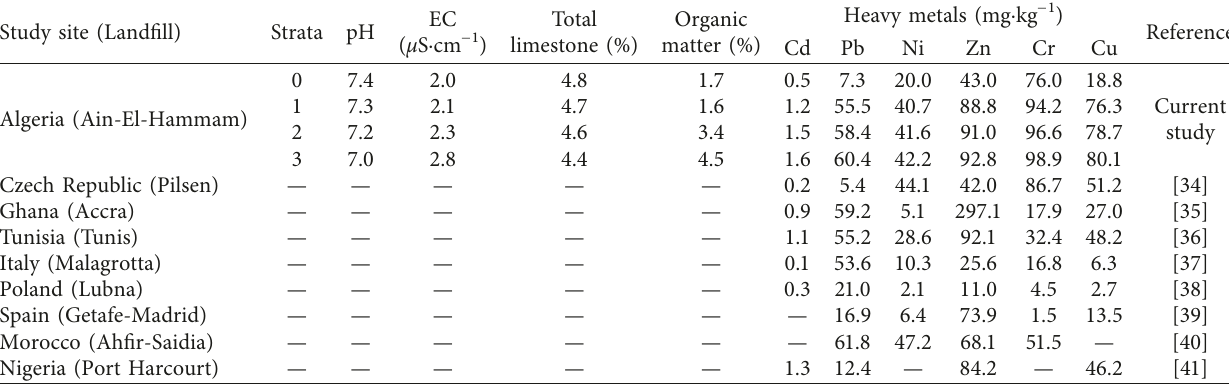
Table 3: Physicochemical analysis of the landfill soil of A.E.H. compared with previous studies. Study site